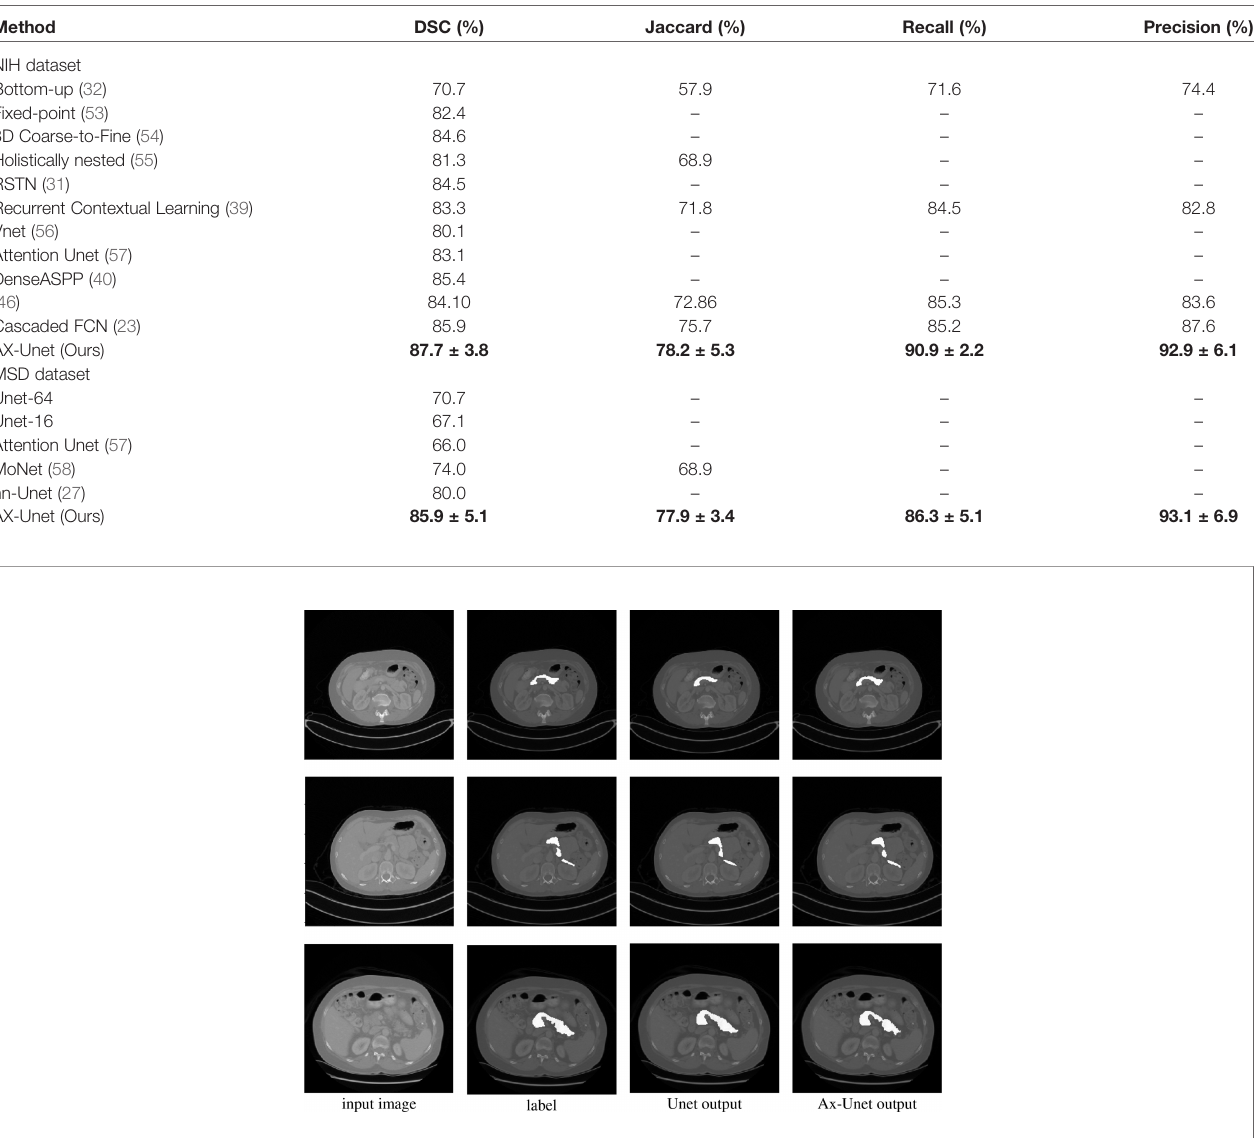
TABLE 2 | The average four-fold performance on two public dataset (the performance of our method is described by mean ± std ).